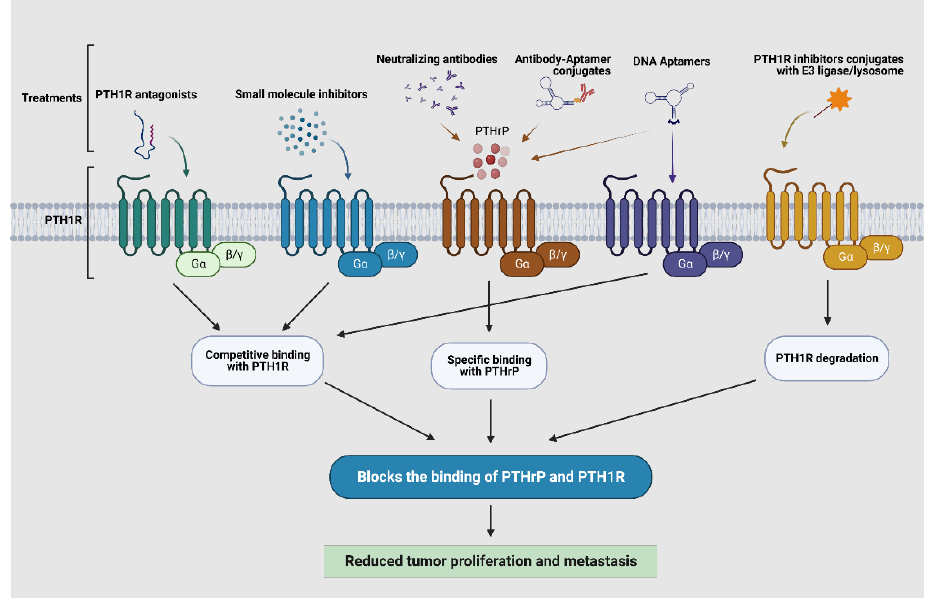
Figure 4. Current and prospective approaches to target PTHrP/PTH1R.